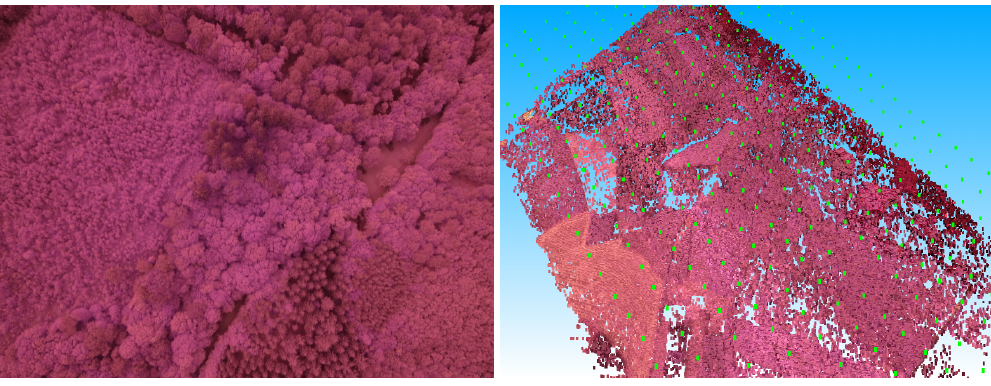
Elements of the orientation of individual aerial images were computed by automatic aerotriangulation. ( Left ) One of the 439 images; ( Right ) the aerotriangulated model. Camera poses are displayed with green